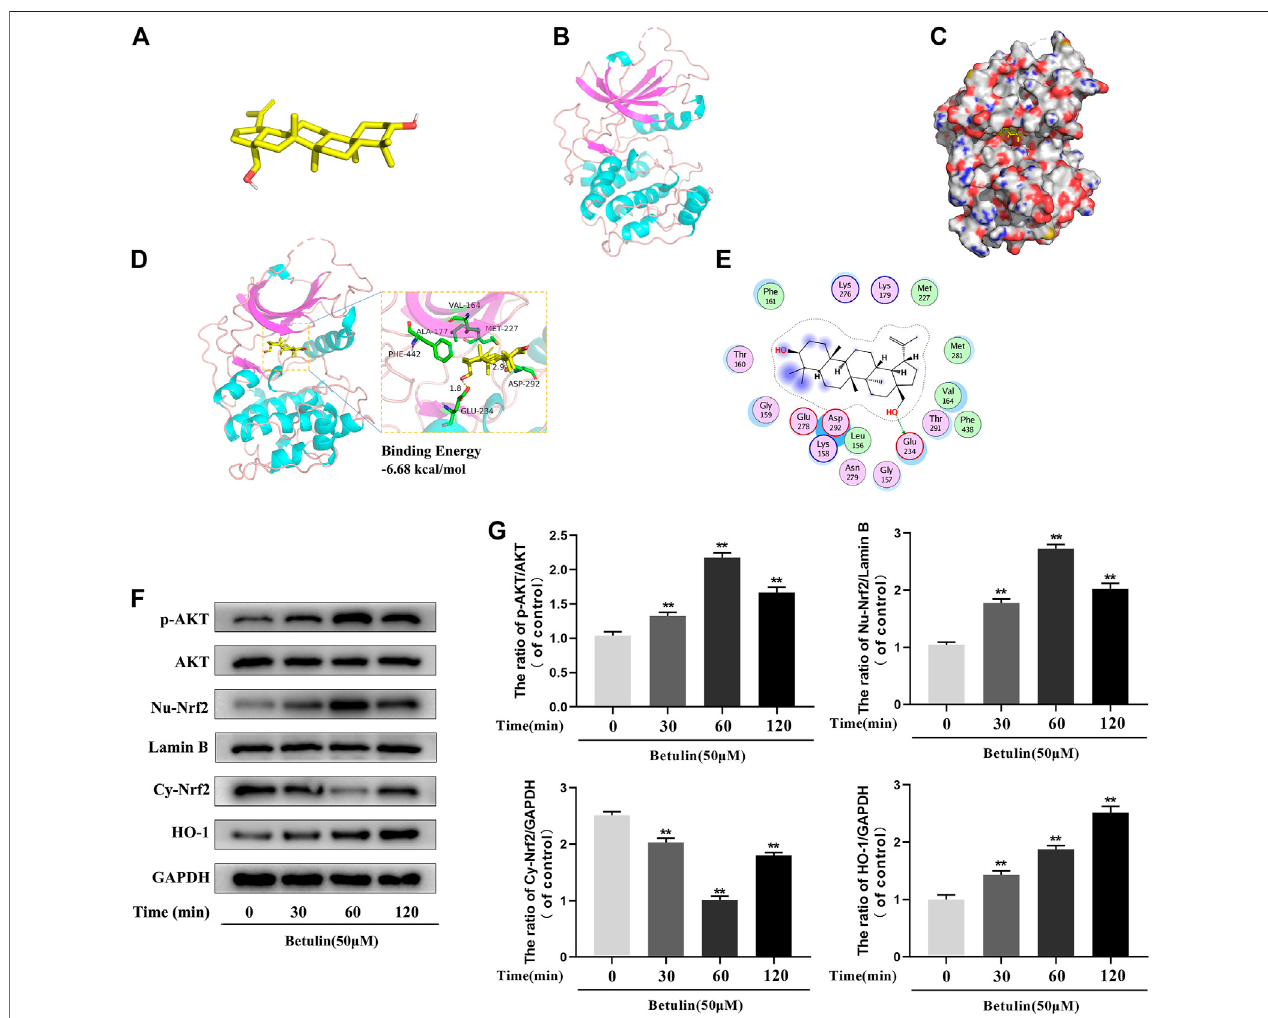
FIGURE 5 | The molecular docking model shows the af fi nity between Betulin and AKT. Betulin promotes the phosphorylation of AKT, enhances the nuclear expression of Nrf2, and upregulates the expression of HO-1. (A) The model of Betulin. (B) The ribbon model of AKT. (C) The space fi lling model of the binding of Betulin and AKT protein. (D) Three-dimensional (3D) binding model between Betulin and AKT protein. The backbone of the protein was rendered in tube and appears bright blue;Betulinisrenderedyellow;theyellowdashrepresentsthehydrogenbonddistance,andthebindingenergyofthetwois − 6.68 kcal/mol. (E) Two-dimensional bindingmodel betweenBetulinand AKTprotein. The chondrocytes weretreated withbetulin (50 μ M) for0,30,60, and120 min. (F – G) Theprotein levelsofnuclear Nrf2 (Nu-Nrf2), p-AKT, HO-1, and cytoplasmic Nrf2 (Cy-Nrf2) were detected by Western blotting and quantitatively analyzed. The data in the fi gure are represented as the mean ± SD, ** p < 0.01 compared with the control group, n (cid:2) 3.